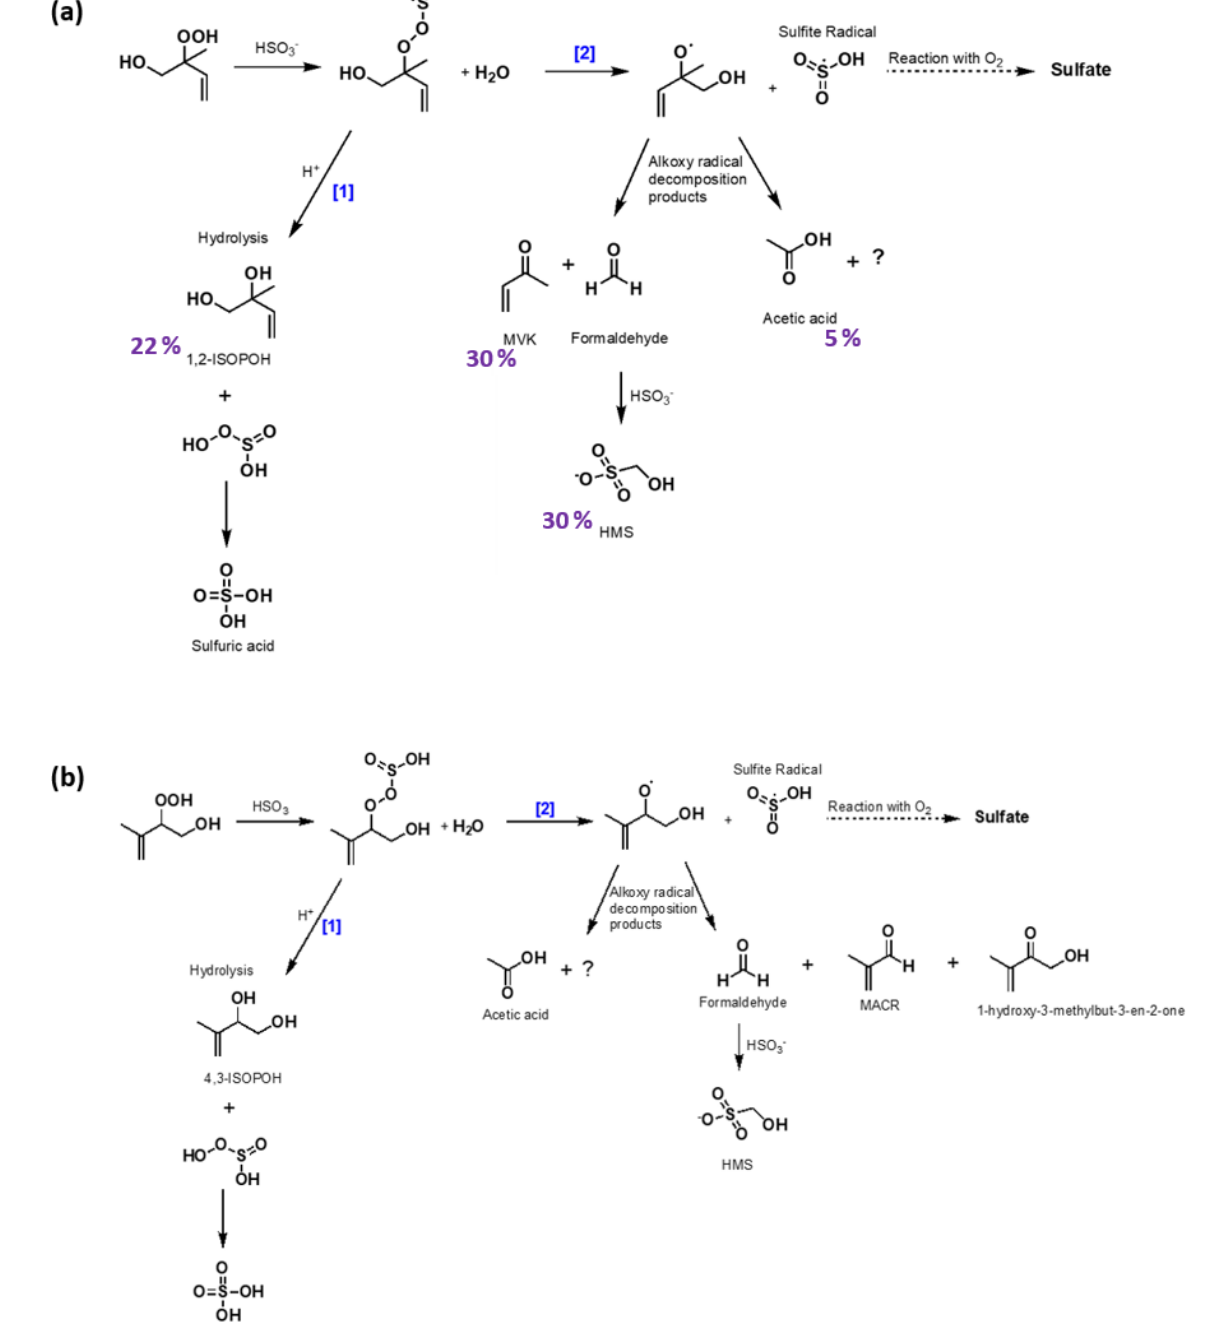
Figure 3. Proposed chemical mechanisms of the oxidation of SO 2 , aq by (a) 1,2-ISOPOOH with carbon yields of identified products at pH = 5.5 (Table 2) presented in purple and (b) 4,3-ISOPOOH. There are two competing mechanisms: after ISOPOOH reacts with SO 2 , aq , displacing water, a hydrolysis reaction [1] or an O − O bond breakage [2] is taking place. In mechanism [1], the product hydrolysis results in the same intermediate that the reaction of SO 2 , aq with H 2 O 2 is forming, and either a formation of a diol or an epoxide is being generated (Fig. S2). In mechanism [2], an alkoxy radical and sulfite radical are formed leading to the production of MVK, MACR, HCHO and other products. Considering the reaction of SO 2 , aq with 1,2-ISOPOOH (a) , the sum of the products’ carbon yields is 57% and the remaining 43% is attributed to hydrated formaldehyde, repartition of MVK to the gas phase, and possible formation of CO or other small molecules that have repartitioned to the gas phase, as discussed in Sect.